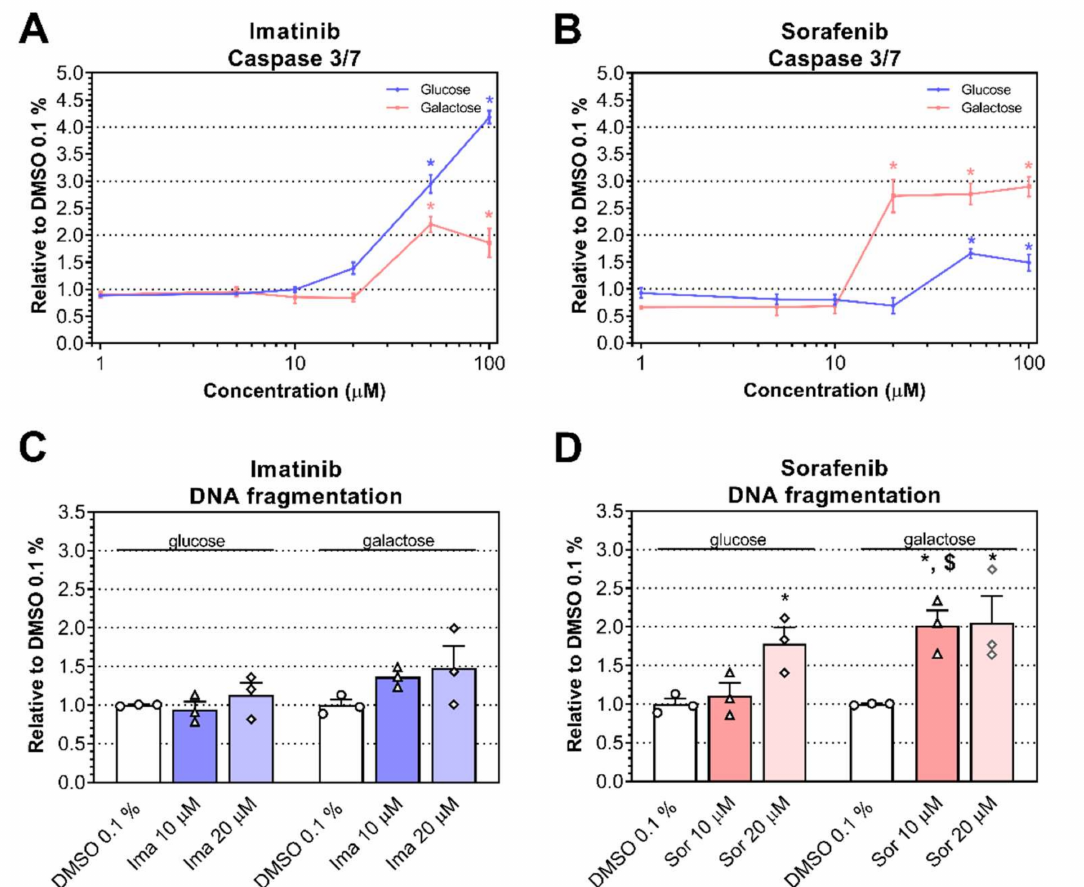
Figure 6. Effects of imatinib (Ima) and sorafenib (Sor) on markers of apoptosis in H9c2 cells under glucose and galactose media. ( A , B ) Caspase 3/7 activity after exposure to imatinib ( A ) and sorafenib ( B ) for 24 h under glucose and galactose media. ( C , D ) DNA fragmentation observed in cardiomy- oblast H9c2 cells after exposure to imatinib ( C ) and sorafenib ( D ) for 24 h under glucose and galactose media. Data represent the mean ± SEM of at least three independent experiments. * P < 0.05 versus 0.1% DMSO control; $ P < 0.05 galactose versus glucose of the same treatment